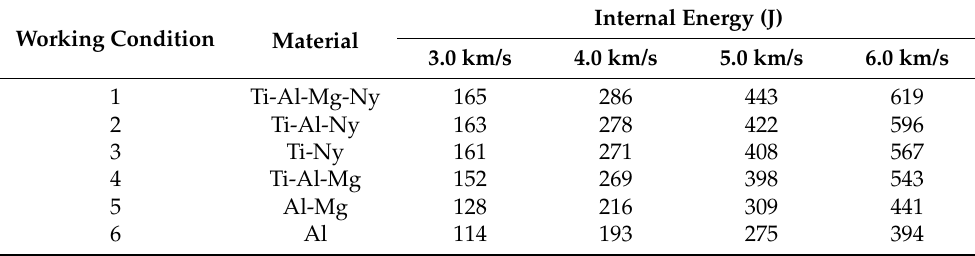
Table 5. Corresponding internal-energy conversion of five protective-screen materials at different impact